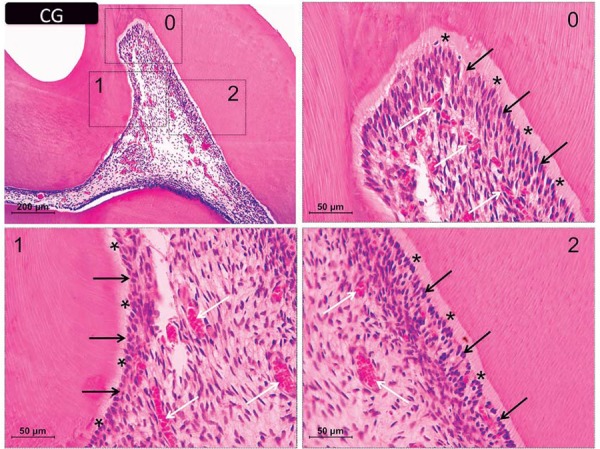
 Representative images of hematoxylin & eosin-stained sections showing the coronal pulp of the controls. Panels 0, 1, and 2 are magnified images (400×) of the respective insets in the upper left panel (100× magnification). The black arrows indicate the odontoblastic layer and the white arrows show the distribution of cells and blood vessels in the subjacent tissue. Asterisks indicate the predentin layer